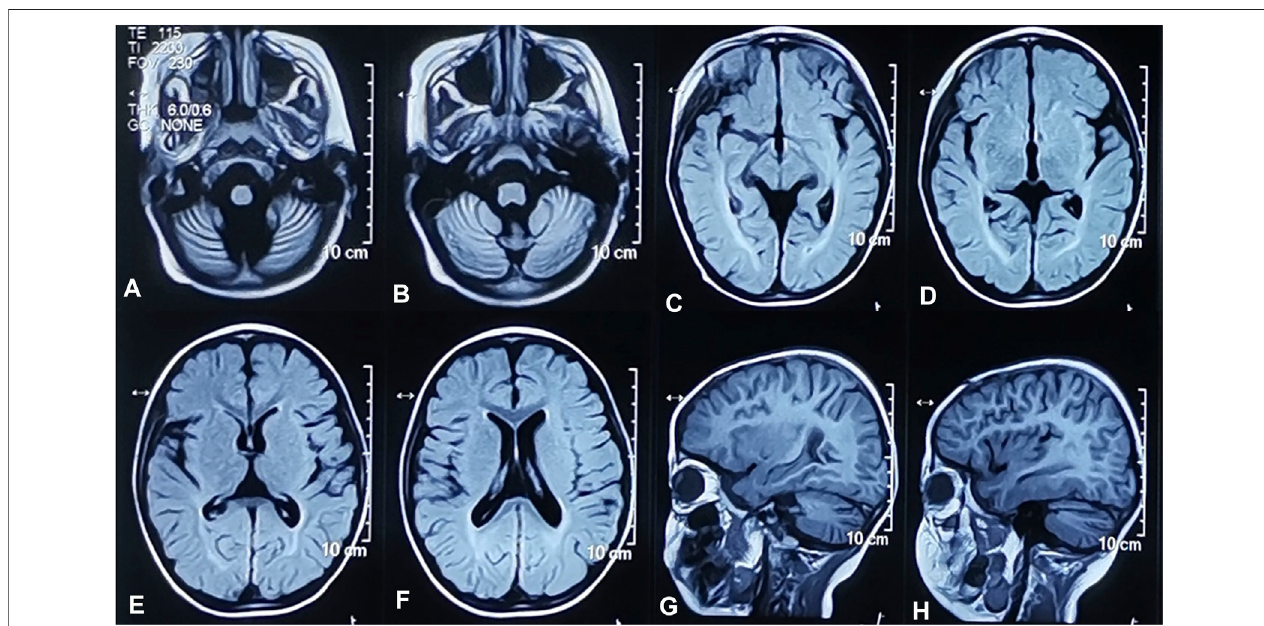
FIGURE1| BrainMRIoftheproband.Widenedcerebellumsulci.AxialT2-weightedFLAIRimage (A,B) .Abnormalsignalsofwhitematterneartheposteriorhornof bilateral lateral ventricles. Axial T2-weighted FLAIR images (C,D) . Widened bilateral cerebral hemispheres sulci. Axial T2-weighted FLAIR image (E,F) . Widened bilateral cerebral hemispheres and cerebellar sulci. Sagittal T1-weighted images (G,H)